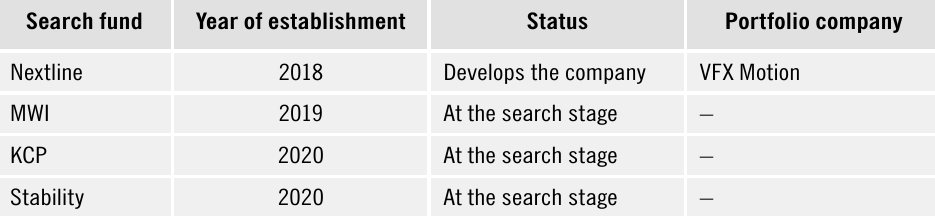
Table 1. Search fund status in Poland as of December 31, 2020